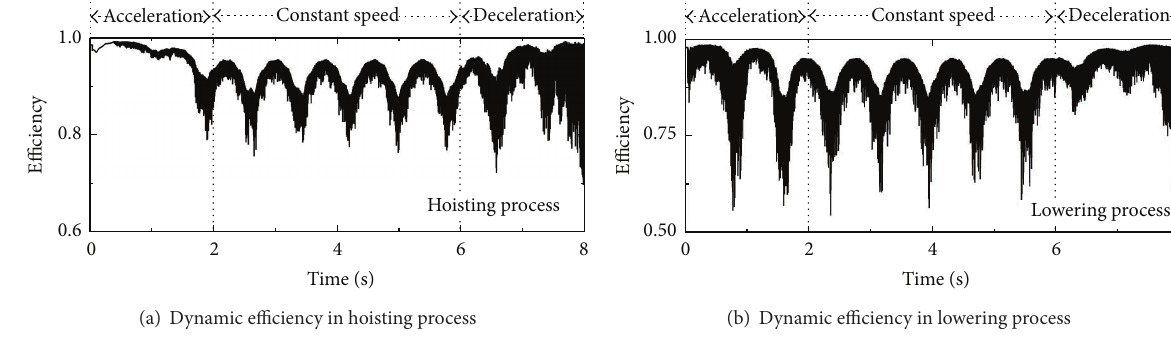
Figure 10: Dynamic efficiency of the gear transmission.